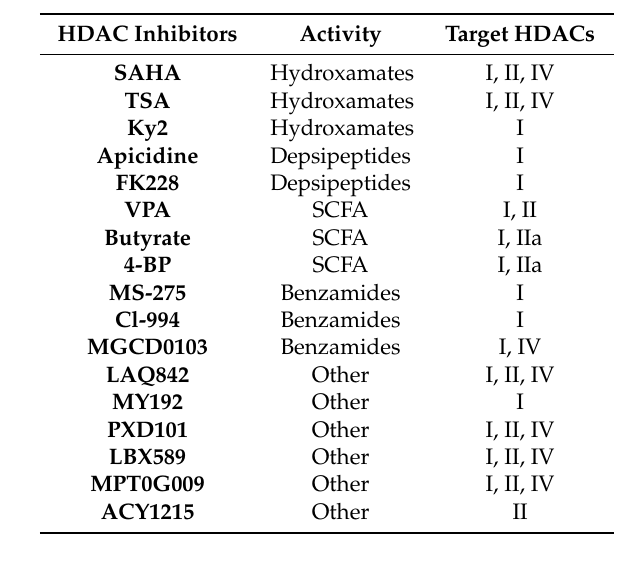
Table 2. Targets of di ff erent HDAC inhibitors (HDACis). SAHA —suberoylanilide hydroxamic acid, TSA —trichostatin A, SCFA —short chain fatty